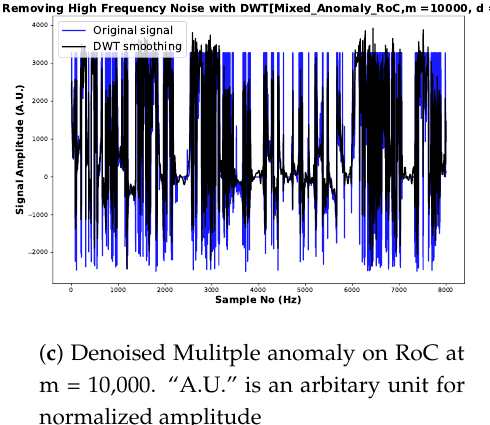
Figure 6. Denoised Multiple anomaly on Speed, Ax and radius of curvature ( RoC ) sensor